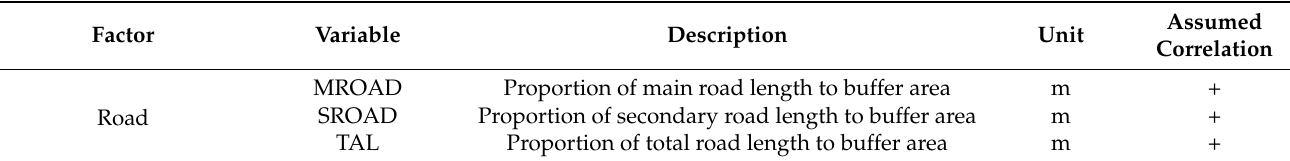
Table 3. Independent variables of LUR